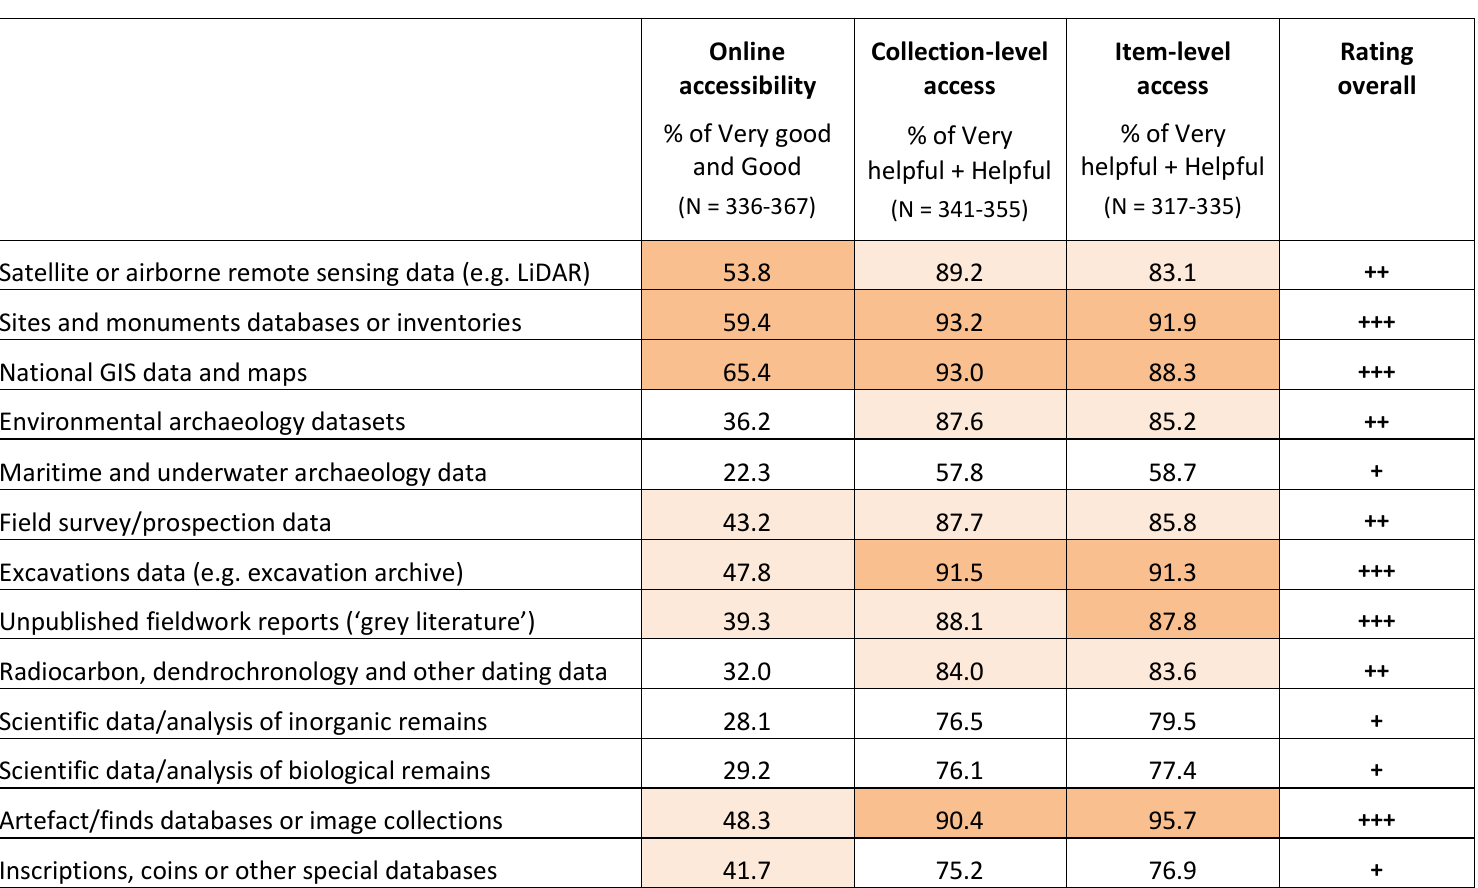
Table 21 : Overview of the results for online accessibility in general and access at collection-level and item-level via the ARIADNEplus data